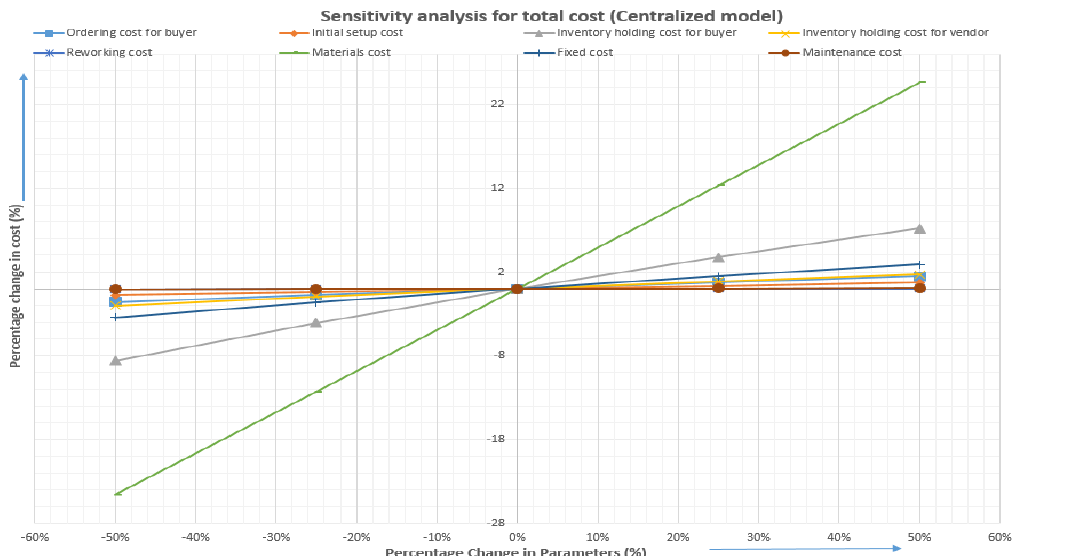
Figure 3. Sensitivity analysis: total cost versus change in parameters under centralized